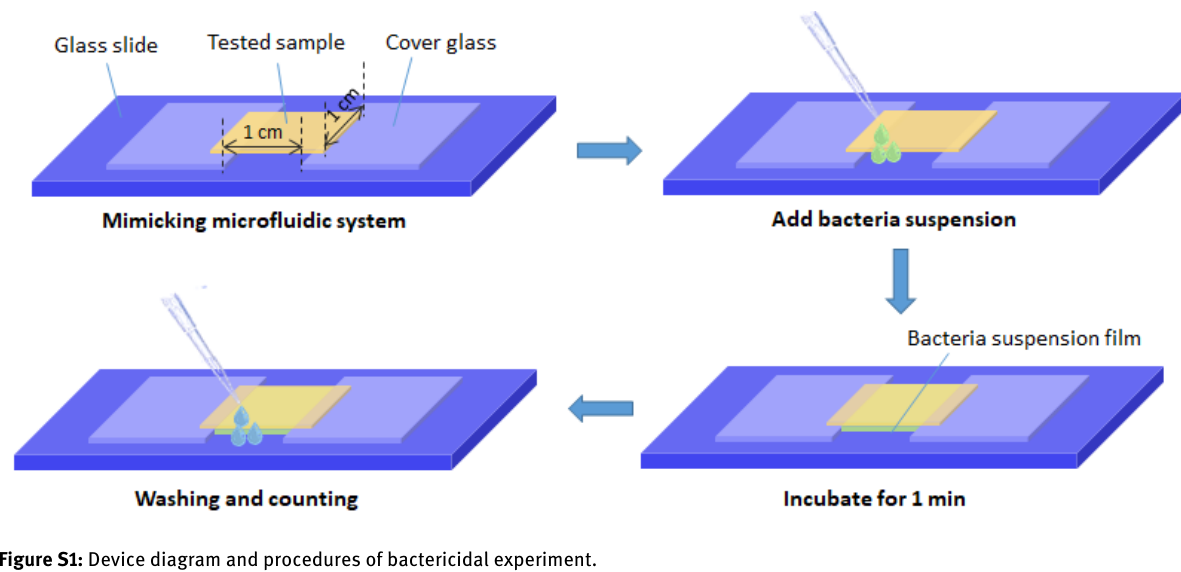
Figure S1: Device diagram and procedures of bactericidal experiment.